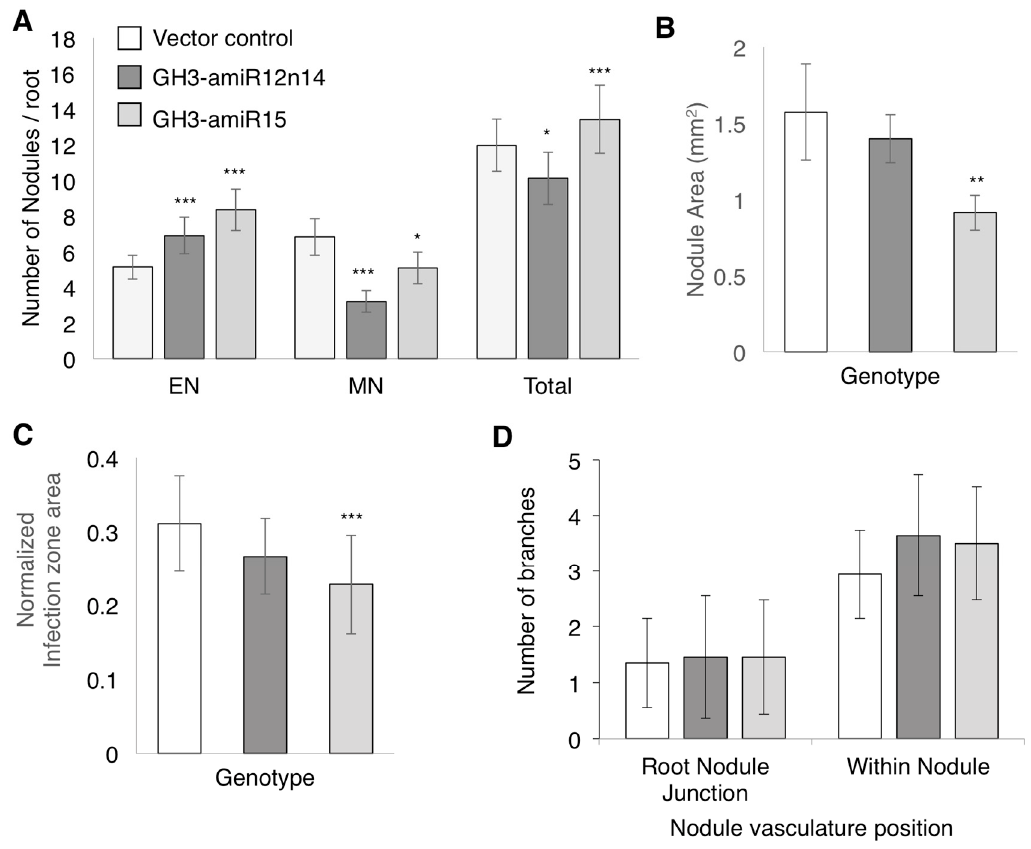
Figure 7. Nodule numbers and morphology in GH3-amiR expressing soybean roots. ( A ) Numbers of emerging, mature, and total nodules in vector control, GH3-amiR12n14, and GH3-amiR15 expressing roots at 17 dpi. Data shown are the averages of at least 68 roots for each construct from three independent experiments. Error bars indicate SE. * p < 0.05, *** p < 0.001, Poisson distribution test; ( B ) Nodule area; and ( C ) normalized infection zone size of mature nodules from vector control, GH3-amiR12n14, and GH3-amiR15 expressing roots. Data shown are averages of at least 15 nodules each from three biological replicates. Error bars indicate SE. ** p < 0.01, *** p < 0.001, Wilcoxon-Mann-Whitney test; ( D ) Number of vasculature branches detectable at the root-nodule junction and within the nodule in transverse sections of mature nodules from vector control, GH3-amiR12n14, and GH3-amiR15 expressing roots. Data shown in C are averages of at least 15 nodules each from three biological replicates. Error bars indicate SE. Student’s t -test.